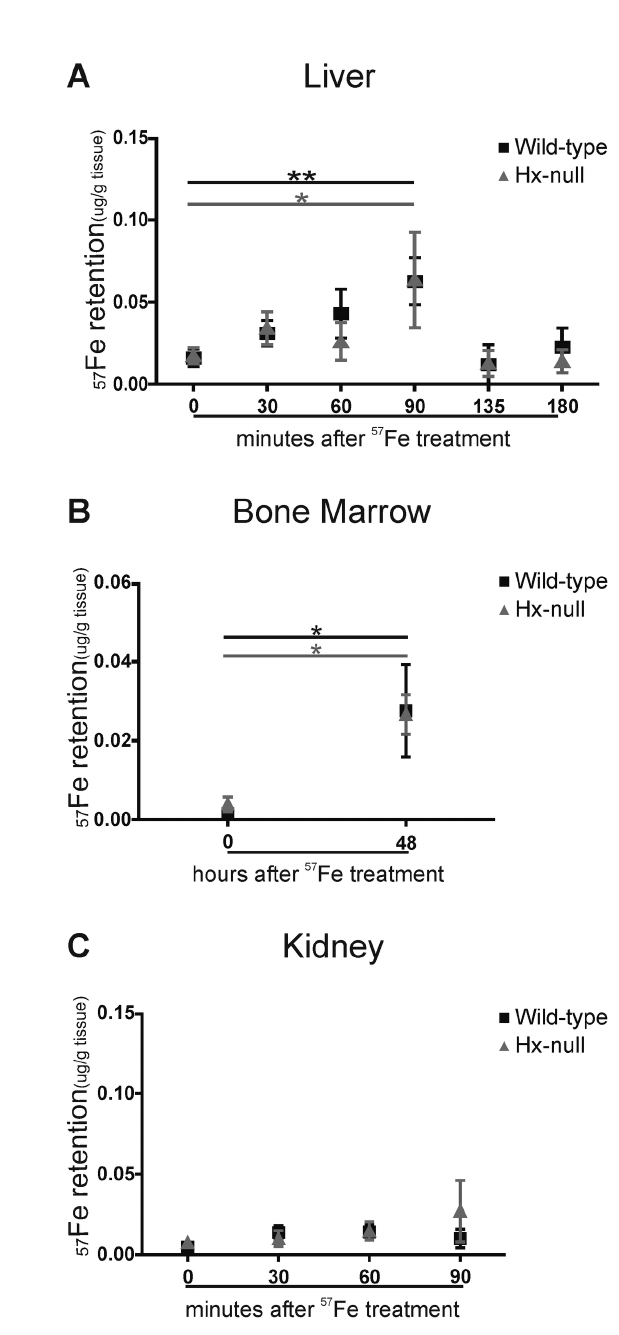
Figure 7. Hx deficiency does not affect iron transfer from the duodenum to other tissues. (A) 57 Fe retention in the liver of wild-type and Hx-null mice measured by ICP-MS 30, 60, 90, 135 and 180 minutes after oral administration of a solution containing 20 mmol/L 57 FeSO . Control mice were administered vehicle solution and represented the “0” time point of the experiment. Values 4 are expressed as μg 57 Fe/ g tissue. Data represent mean ± SEM; n=6 for each experimental point; * = P<0.05, ** = P<0.01 (comparing control mice with the corresponding group of 57 FeSO -administered mice). (B) 57 Fe retention in the bone marrow of wild- 4 type and Hx-null mice measured by ICP-MS 48 hours after oral administration of a solution containing 20 mmol/L 57 FeSO . Control 4 mice were administered vehicle solution and represented the “0” time point of the experiment. Values are expressed as μg 57 Fe/ g tissue. Data represent mean ± SEM; n=10 for each experimental point; * = P<0.05. (C) 57 Fe retention in the kidney of wild-type and Hx-null mice measured by ICP-MS 30, 60, and 90 minutes after oral administration of a solution containing 20 mmol/L 57 FeSO . 4 Control mice were administered vehicle solution and represented the “0” time point of the experiment. Values are expressed as μg 57 Fe/ g tissue. Data represent mean ± SEM; n=6 for each experimental point. doi: 10.1371/journal.pone.0068146.g007 PLOS ONE |